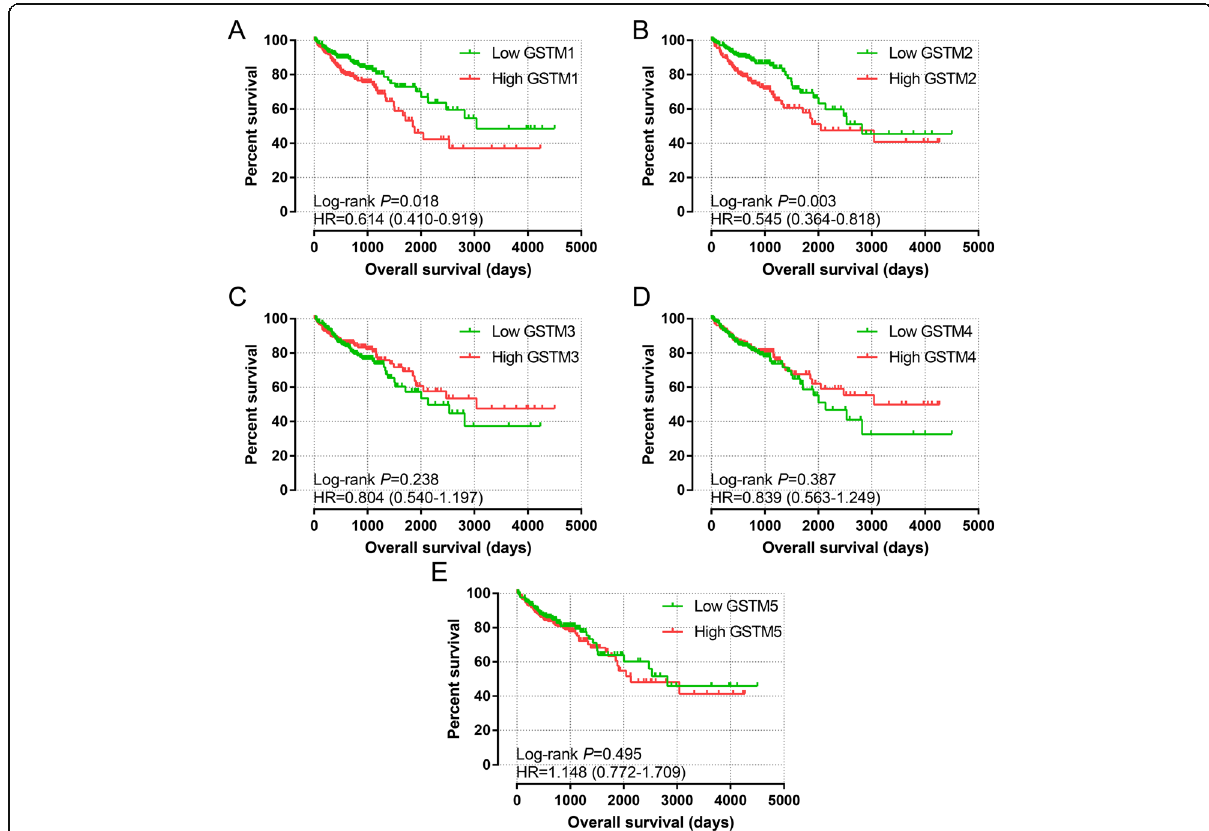
Fig. 4 Prognostic value of GSTM expression for OS. ( a – e ) Kaplan-Meier survival curves for COAD patients according to GSTM1 ( a ), GSTM2 ( b ),